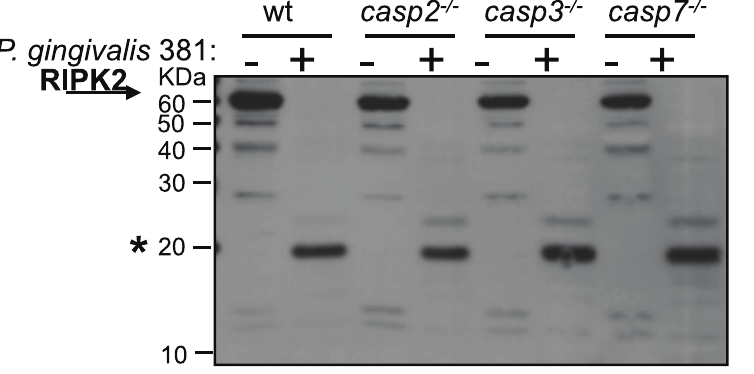
Figure 6. P.gingivalis modifies RIPK2 in wild type and caspase-deficient murine bone marrow-derived macrophages. A ) C57BL/6 ( wt ) or casp1 -deficient ( casp1 2 / 2 ) BMDM were untreated ( M ) or treated with 100 ng/ml E. coli LPS ( LPS ), live P. gingivalis 381 (MOI 100, Live ) or heat- killed (60 u C, 60 min) P. gingivalis 381 (MOI 100 equivalency, HK ) for 2 h. B ) C57BL/6 ( wt ), casp2 -deficient ( casp2 2 / 2 ), casp3 -deficient ( casp3 2 / 2 ), or casp7 -deficient ( casp7 2 / 2 ) BMDM were untreated ( 2 ) or treated with P. gingivalis 381 (MOI 100) ( + ) for 2 h. Whole cell lysates were analyzed for RIPK2. Full-length RIPK2 is indicated with an arrow. A prominent P. gingivalis -induced LMW band is indicated with an asterisk. MW ladder is indicated on the left in